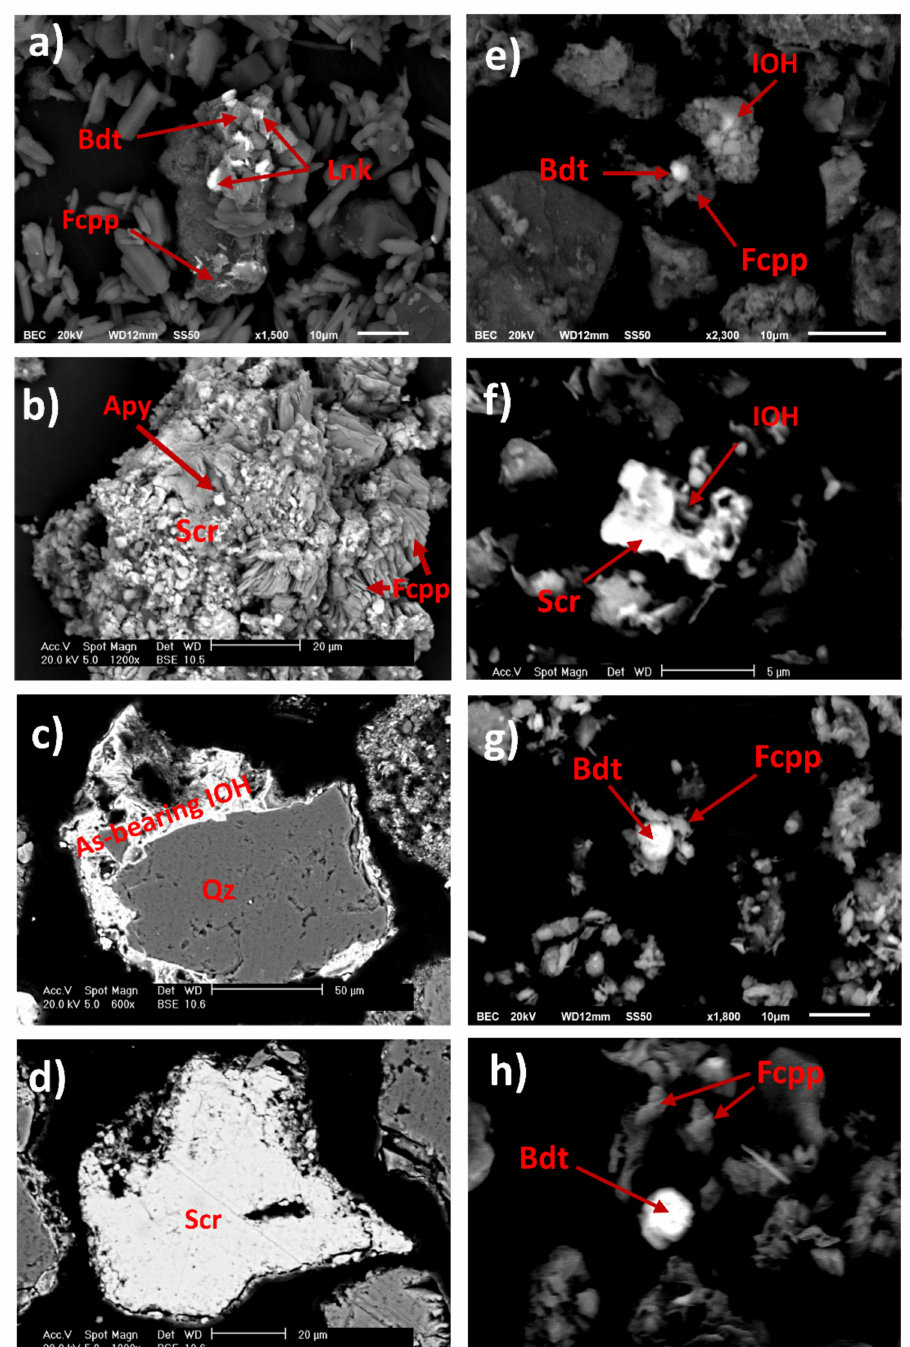
Figure 8. Photomicrographs of particles present on the wall of AMWD4 ( a ) and ( b ); stream sediments XS1 ( c ) and ( d ), XS2 ( e ), XS3 ( f ) and ( g ), and XS4 ( h ). SEM-EDS point analysis suggests the presence of arsenopyrite (Apy), beudantite (Bdt), scorodite (Scr), As-bearing IOH, ferricopiapite (Fcpp), and lanarkite (Lnk) (see Table